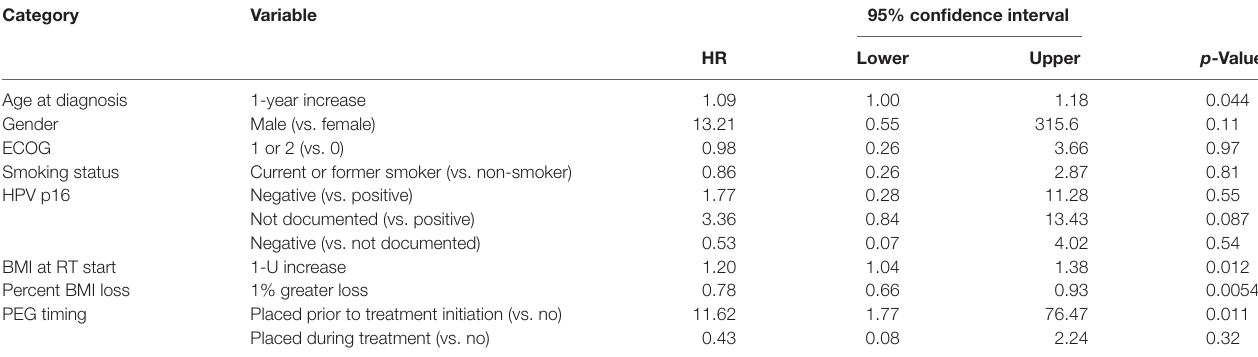
Table 3 | Multivariate analysis of association with time to